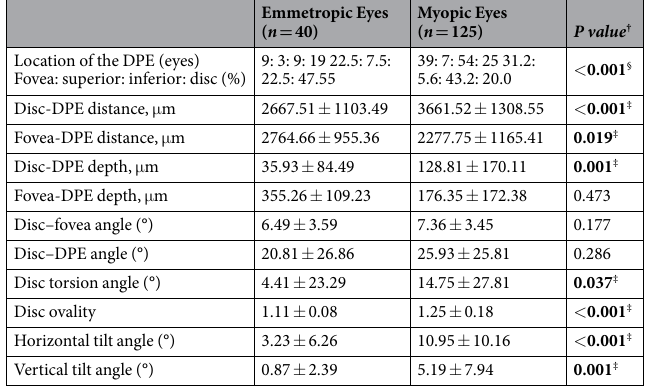
Table 3. Comparison of DPE properties and optic disc configuration between emmetropic and myopic eyes * . DPE: deepest point of the eyeball. * Data are presented as mean ± standard deviation unless otherwise indicated. † Independent t -test for continuous variables. ‡ Statistically significant values ( P < 0.05) are shown in bold. § χ ² test for categorical